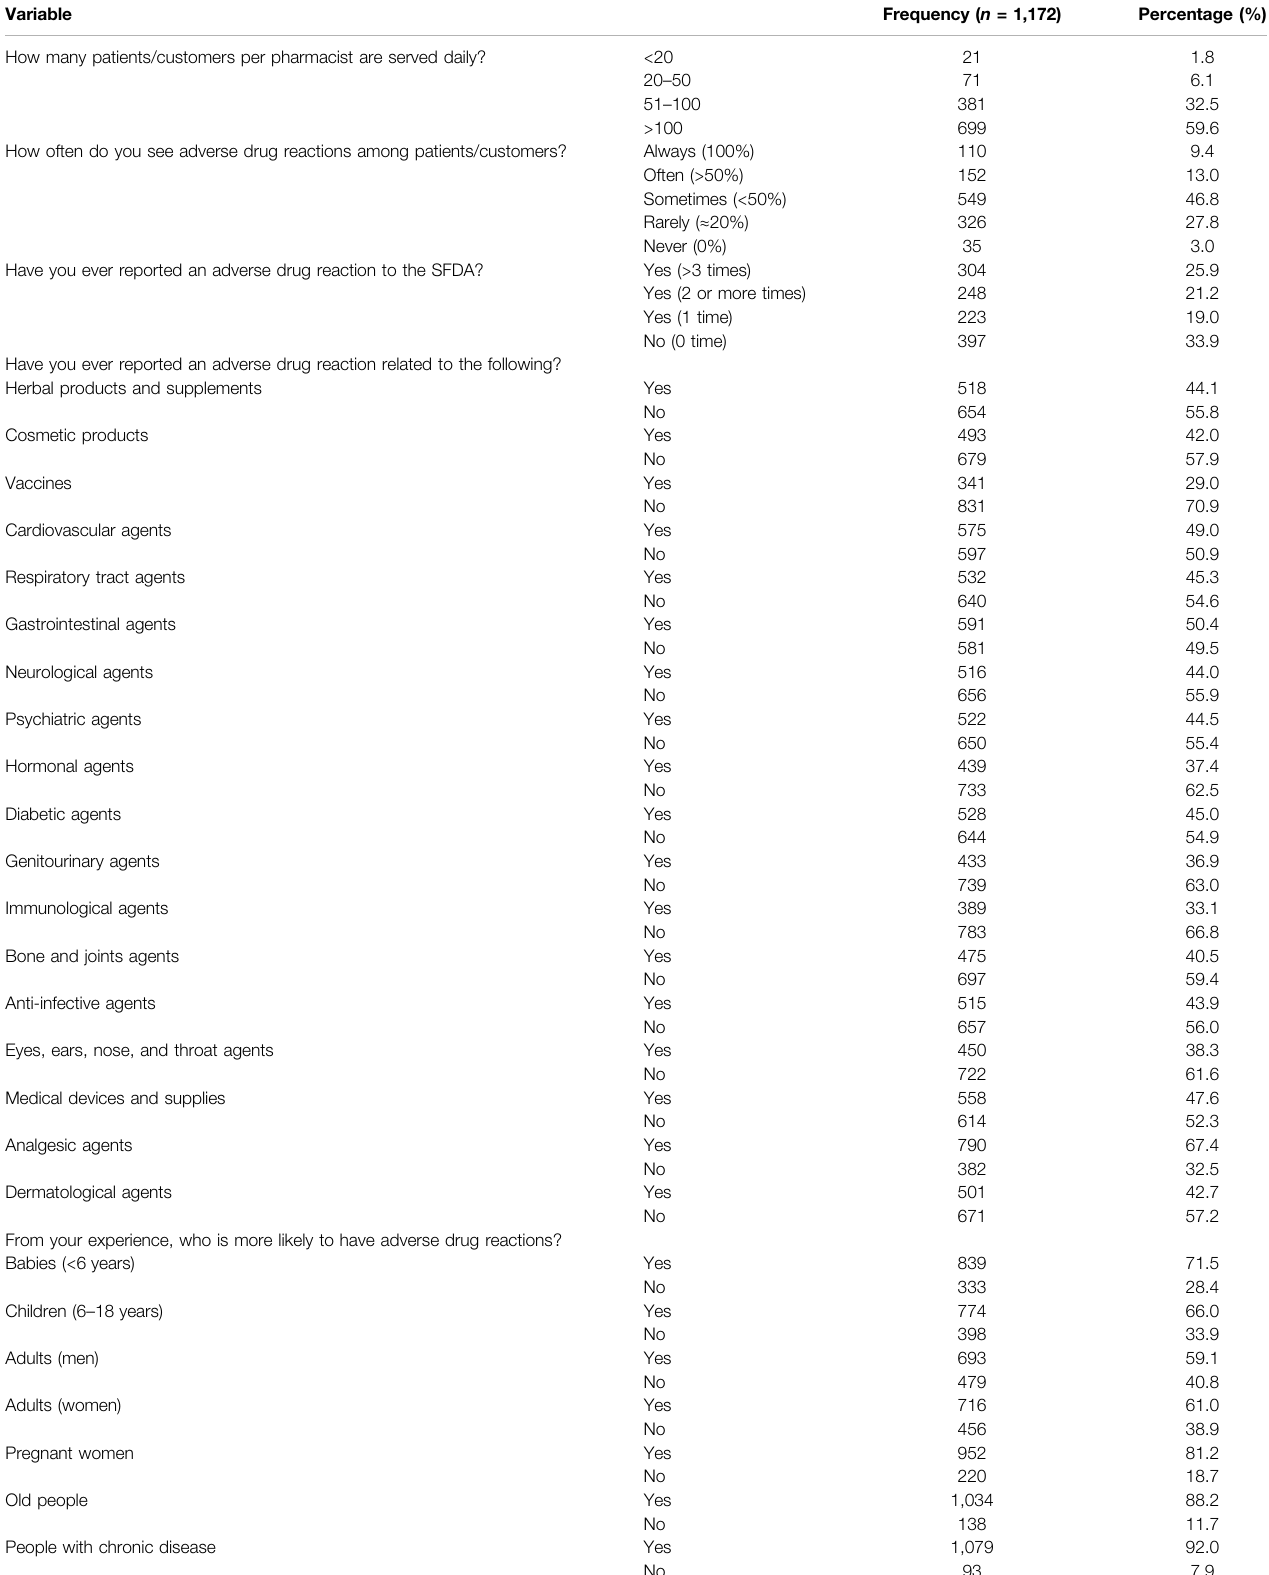
TABLE 5 | Pharmacovigilance and ADR reporting practices of respondent